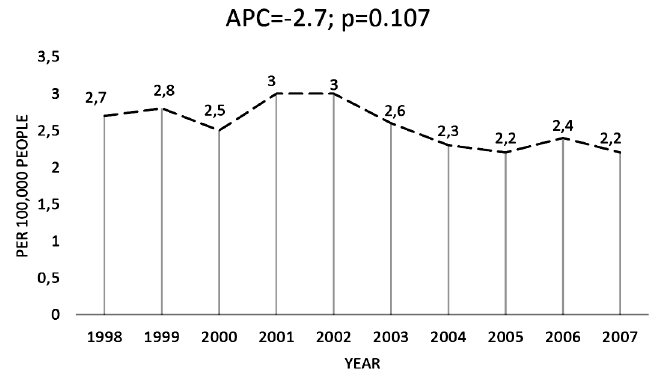
Figure 7. Syphilis incidence rates in the years 1998–2007